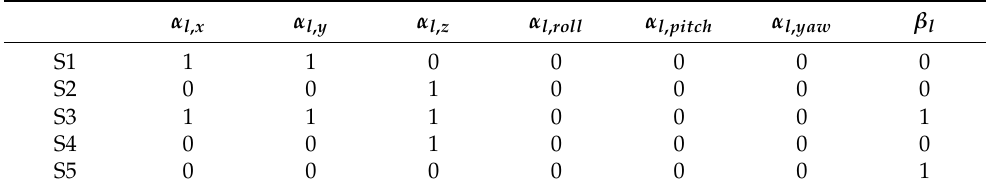
Table 2. The predefined parameters related to the right robot.